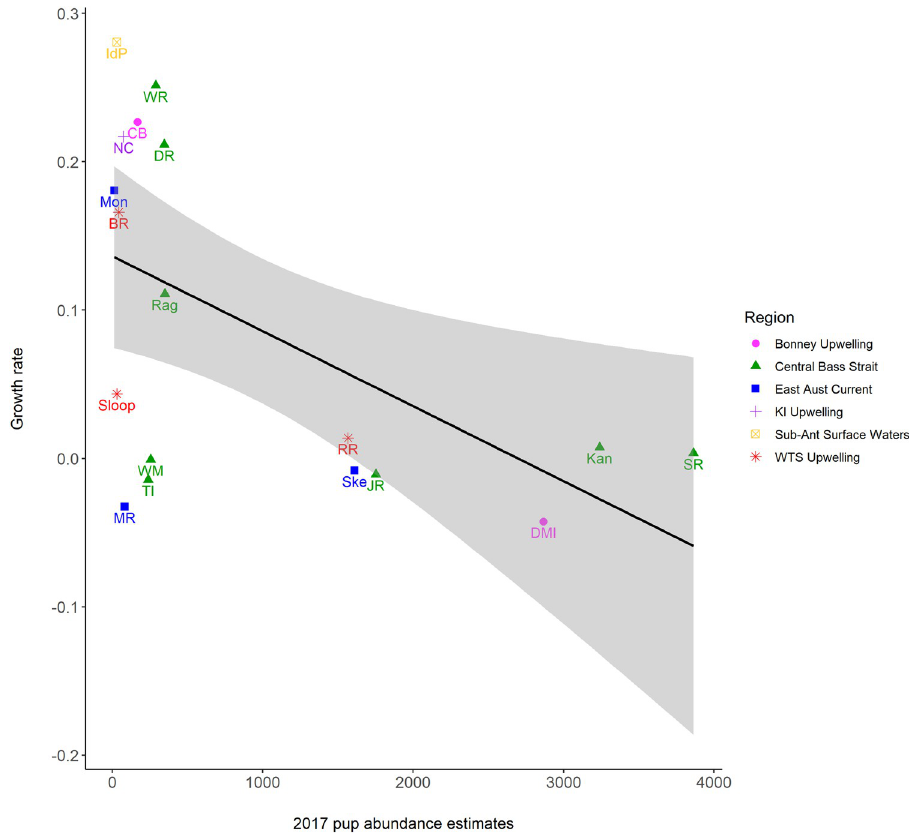
Fig 5. Scatterplot and linear regression (black line) of the rate of change (Growth rate or β Year Table 3) of each breeding colony (shown using abbreviations defined in Table 1 and Fig 4) in response to the 2017 pup abundance estimate, with the 95% confidence interval shown by grey shading. Symbols and colours of sites represent the different oceanographic regions where they are situated.